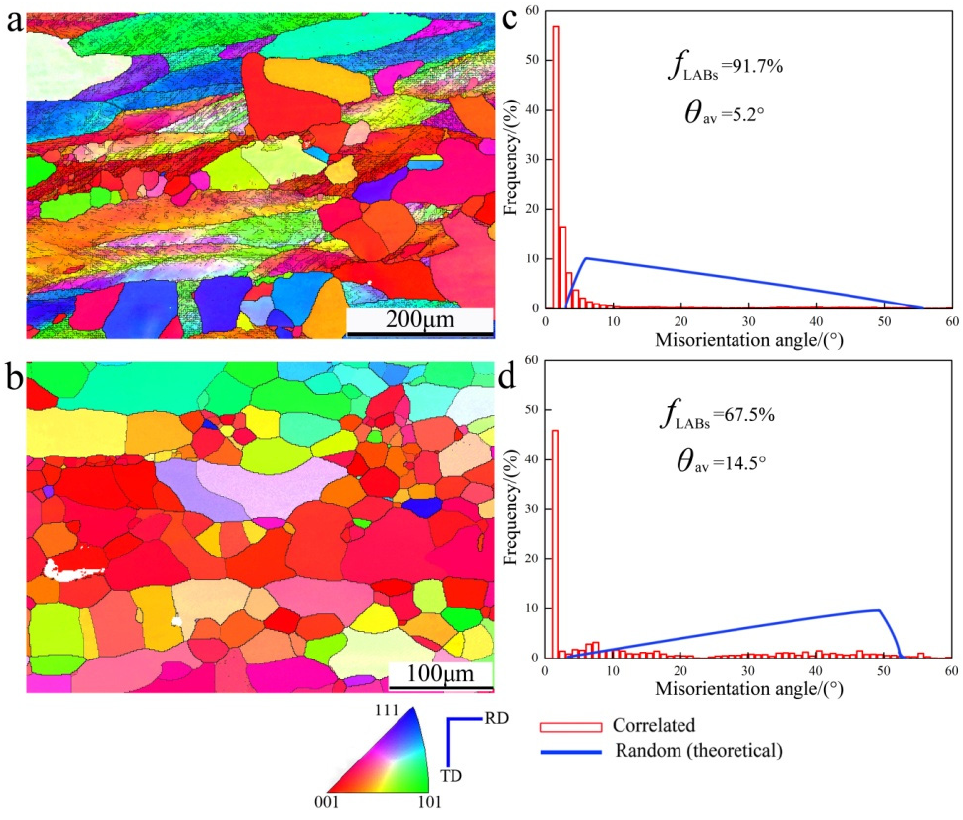
Figure 7. EBSD IPF maps of ( a ) CR-50%, T = 500 °C, t = 120 s; ( b ) CR-85%, T = 500 °C, t = 60 s; ( c , d ) Misorientation angle corresponding to ( a , b ).